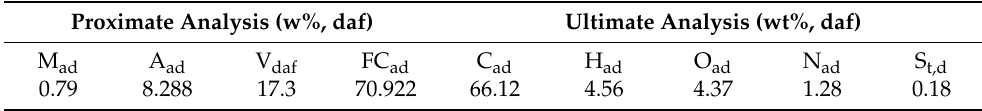
Table 1. The results of elemental and industrial analysis tests.